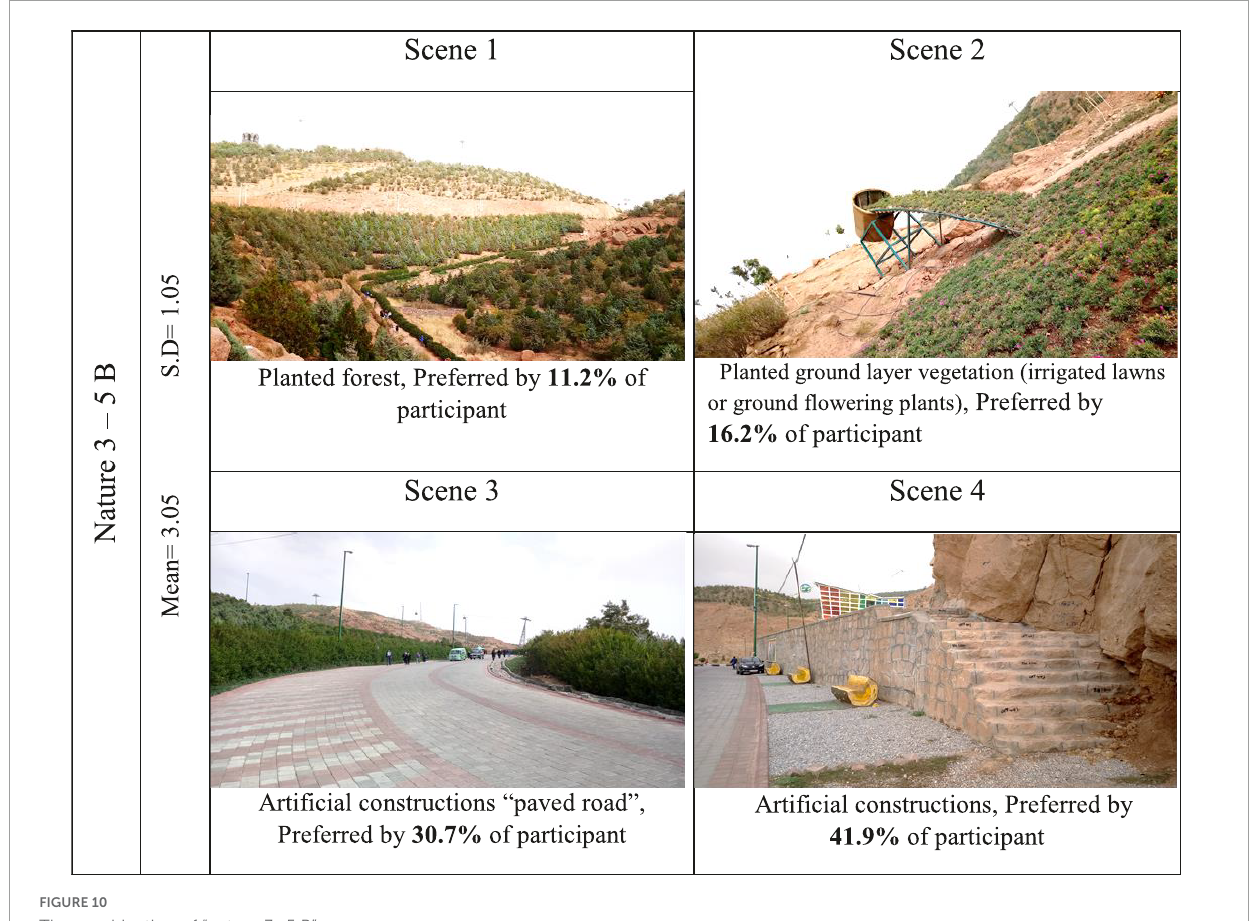
FIGURE10 The combination of “nature 3–5 B”.